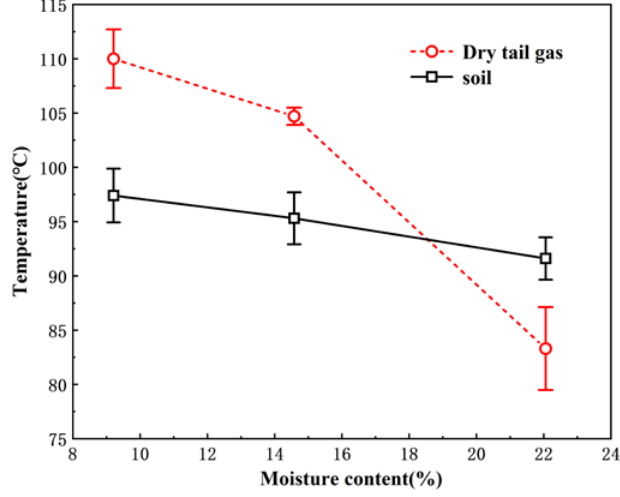
Figure 5. Temperature map of soil and dry tail gas from the rotary dryer for different moisture contents.